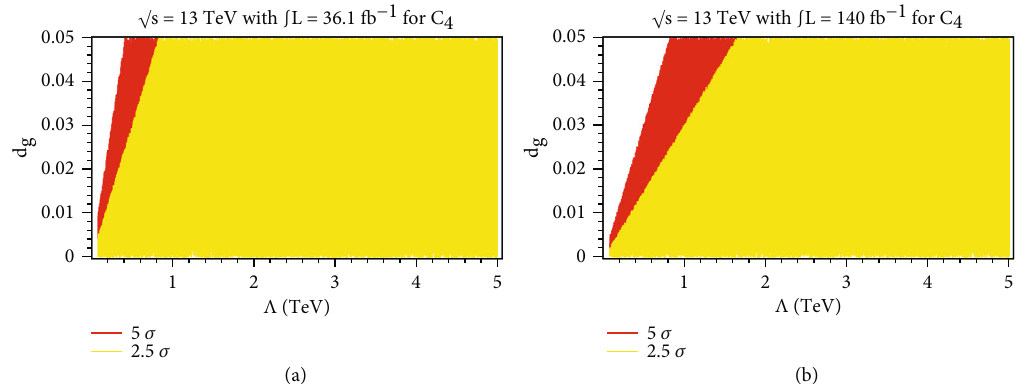
ffiffiffi p at = 13TeV energy at LHC for an integrated luminosity of (a) 36 : 1 fb − 1 and (b) 140fb − 1 respectively. S 4